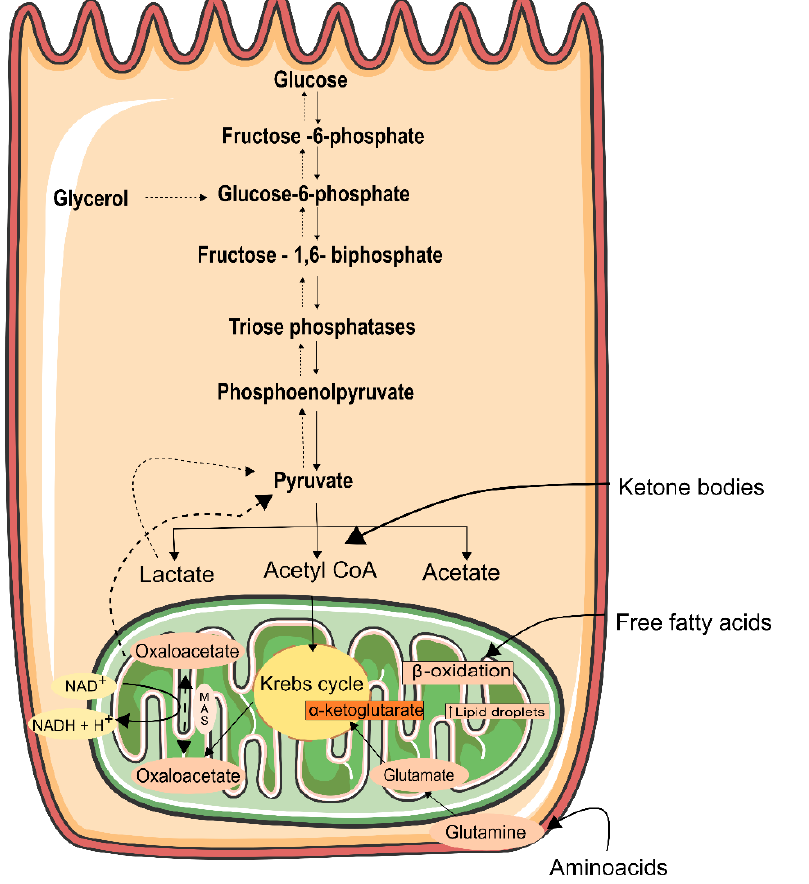
Figure 2. Schematic overview of the major metabolic pathways in renal epithelial cells. Principal substrates used to produce ATP. In renal cells, the uptake of free fatty acids, ketone bodies, glucose, and glutamine lead to increased oxygen consumption and ATP production, through ATP synthase. Glucose, in distal tubules in the healthy kidney, is metabolized to glucose-6-phosphate which is converted into Fructose-1,6-biphosphate. Then, Fructose-1,6-biphosphate is cleaved into two phosphorylated three-carbon compounds glyceraldehyde 3-phosphate and dihydroxyacetone phosphate), known as triose phosphatases. Afterward, glyceraldehyde 3-phosphate is converted into phosphoenolpyruvate and finally into pyruvate. Free fatty acid oxidation is a more efficient substrate to use than glucose in terms of energy production; however, in diabetic nephropathy disease, some complications occurred, i.e., increasing of lipid droplets. Within the cortex, ketones bodies are also a substrate used for ATP production. Glycerol becomes an important gluconeogenic precursor in diabetes. It is broken into glucose-6-phosphate and then be transformed into pyruvate and continues to follow the same path as glucose metabolization. Gluconeogenesis (up dashed arrows), which occurs in proximal tubules cells, needs ATP to produce glucose, which can be synthe- sized from lactate, and glycerol. Glutamine is degraded and converted to glutamate, which can be transaminated via glutamate-oxaloacetate-transaminase or glutamate-alanine-transaminase, which bot reaction yield α -ketoglutarate, an intermediate of Krebs cycle. Pyruvate resulted from lactate, enters into the mitochondria, and is converted to oxaloacetate. Oxaloacetate, in the cytoplasm of the mitochondria, can be reduced to malate and be exported out and/ or in the cytoplasm. Here, through malate aspartate shuttle (MAS), first, malate is oxidized to oxaloacetate and then converted to phosphoenolpyruvate and subsequently converted to fructose-6-phosphate. After a phosphatase, fructose-6-phosphate is dephosphorylated, which results in glucose-6-phosphate, which then is converted into the release of